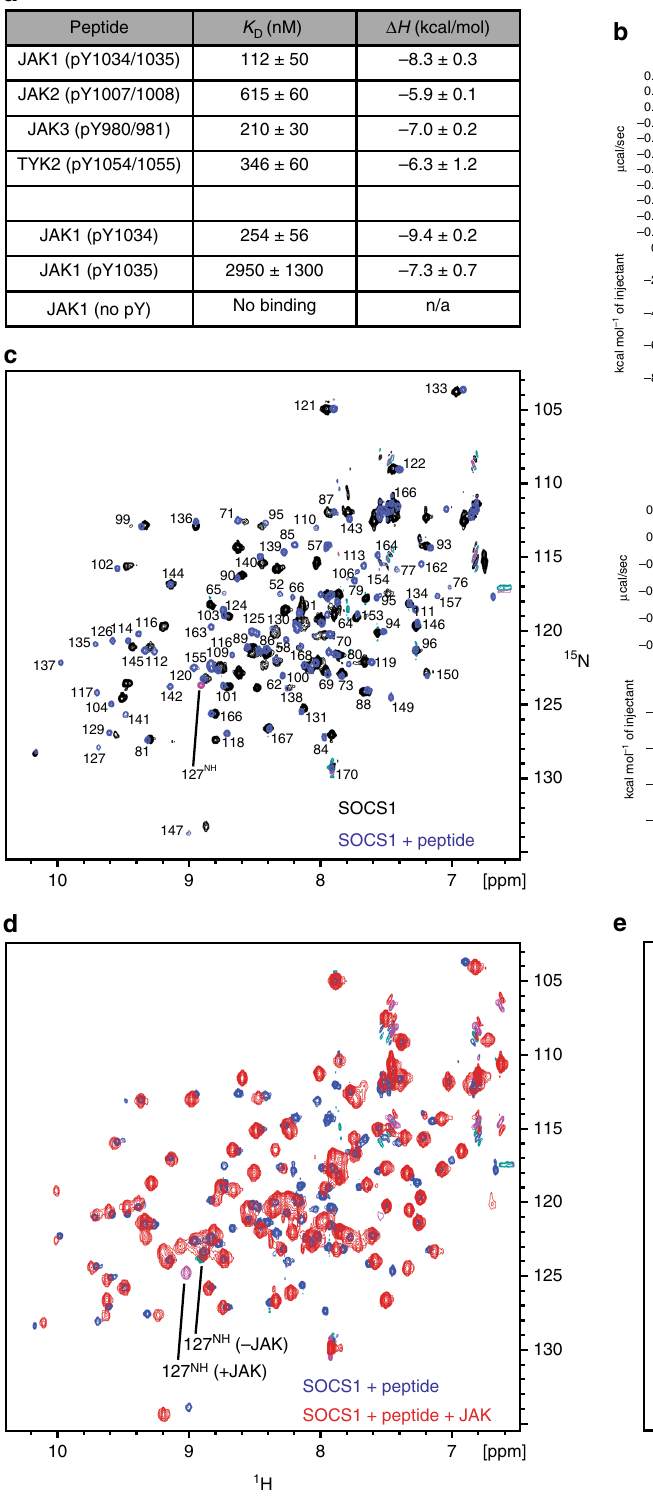
To determine whether SOCS1 can bind JAK (via its KIR) and simultaneously bind a phosphopeptide via its SH2 domain, NMR studies were undertaken. 13 C/ 15 N-labelled gg SOCS1 Δ SOCSbox was expressed and puri fi ed and the resonances assigned. As shown in Fig. 6c, there was a large-scale perturbation of the 15 N-HMQC spectra upon addition of an unlabelled JAK1 activation loop